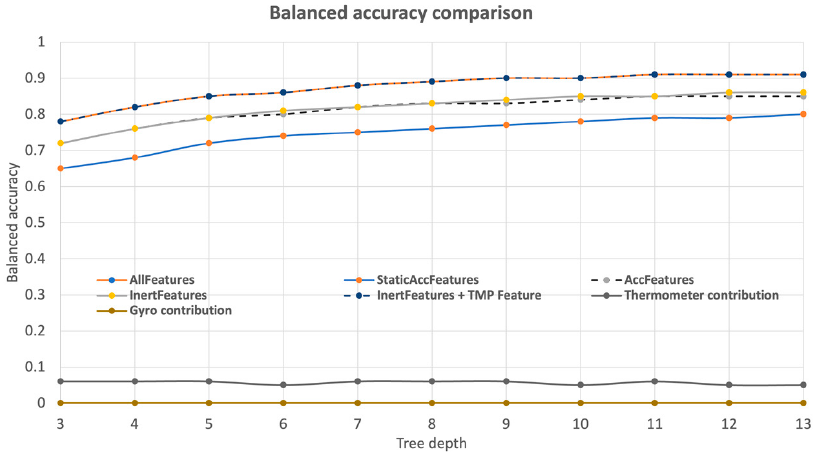
Figure 4. Balanced accuracy evolution with tree depth.